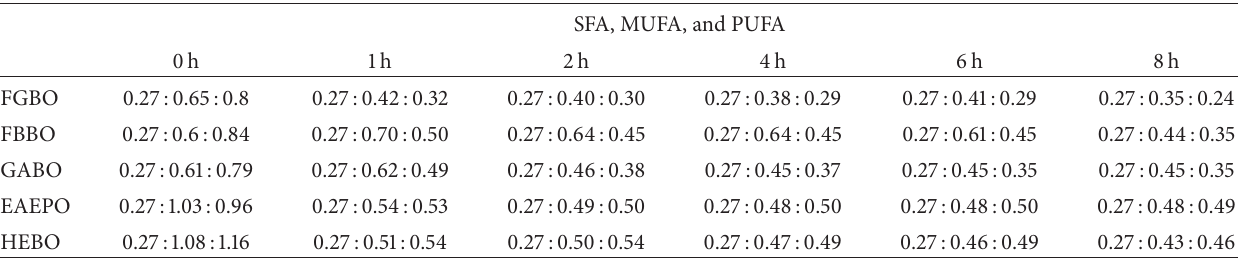
Table 5: Variation of SFA: MUFA:PUFA ratio of blended oils. SFA, MUFA, and PUFA